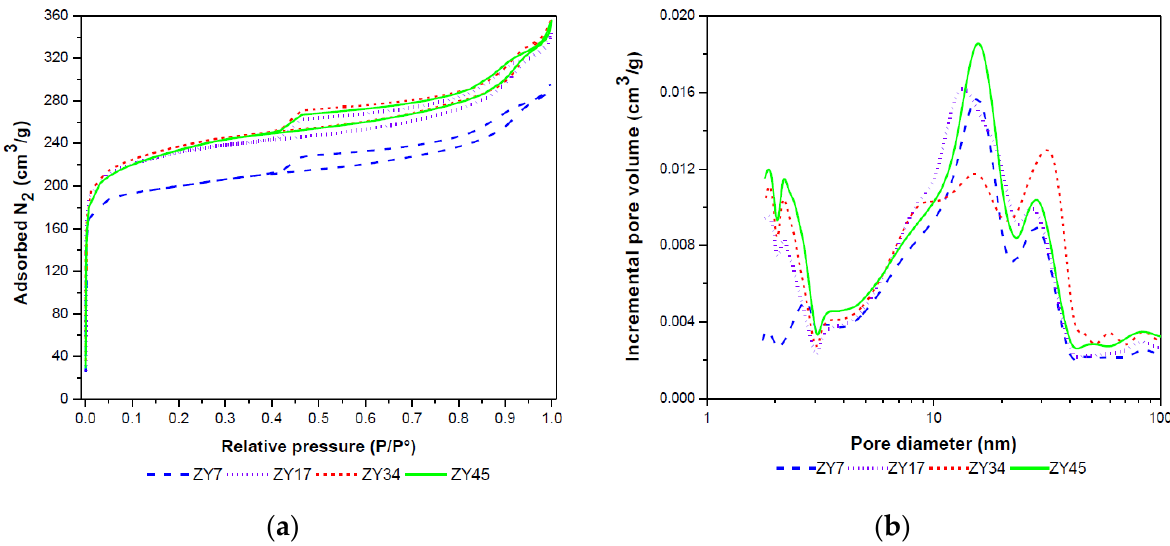
Figure 5. ( a ) N 2 physisorption isotherms, and ( b ) distribution of pore sizes of the Y ‒ type zeolites.